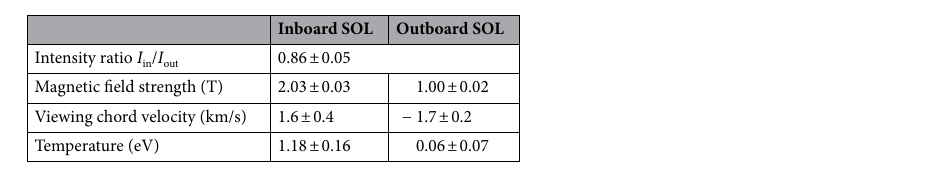
Table 1. Parameters obtained by fitting assuming two-point emission